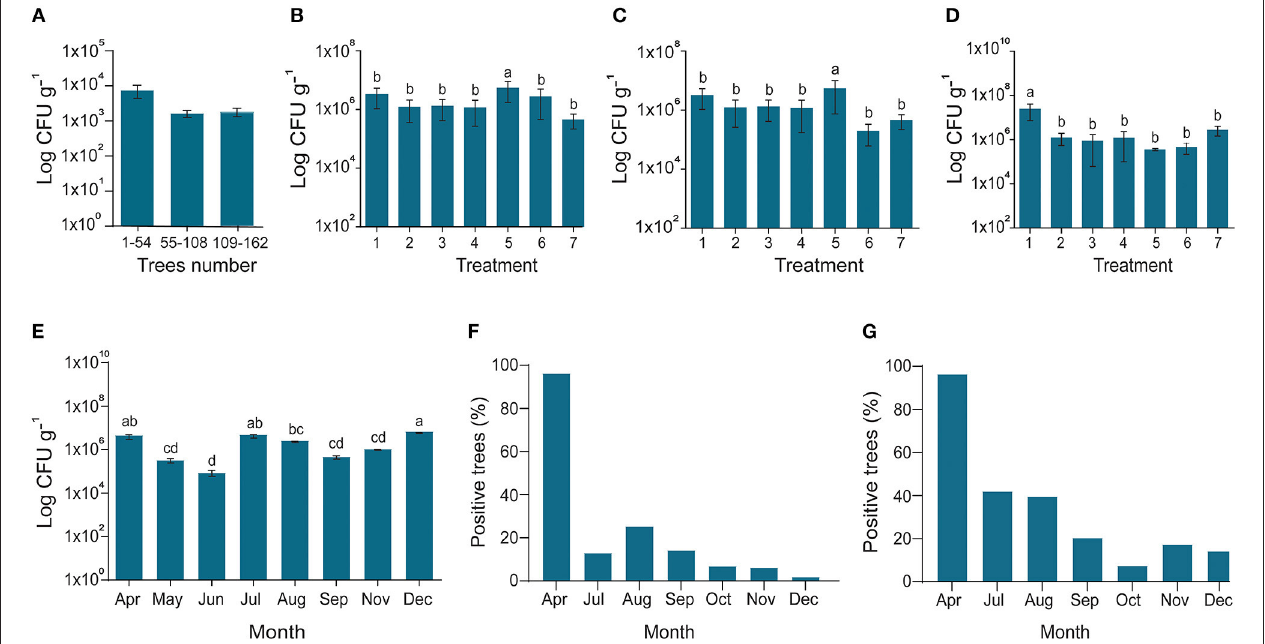
FIGURE 4 | Endophytes density and reduction of C Las pathogen. (A) In March 2017, the diseased citrus trees were checked for possible assessment endophyte before starting experiment; (B) In April 2017, all the trees treated with fertilizer 1 with Bacillus amyloliquefaciens Y2; the X-axis represents endophytes and penicillin injection through the trunk (1); endophyte injection (2); Penicillin spray (3); Endophyte spray (4); Penicillin injection (5); Control CK1 and CK2 (6,7); (C) Fertilizer 2 with B. amyloliquefaciens Y2; CK2 and CK3 (6,7); (D) No organic fertilizer (F 0 ) was used as control; (6,7) indigenous endophytes showing increase in the number of endophytes due to dispersal of endophytes in all the trees even control samples; (E) Endophytes population during different sampling times along with; and (F) Successive reduction of C Las pathogen inside disease trees using conventional PCR and (G) Nested PCR. The populations of endophytic bacteria were calculated based on the average logarithm (base 10) of bacteria recovered from the plant leaves. The log cfu values were analyzed with the GraphPad Prism version 8 (San Diego, California, USA). The values are means ± SD with statistically significant difference among different treatments with different letters ( p ≤